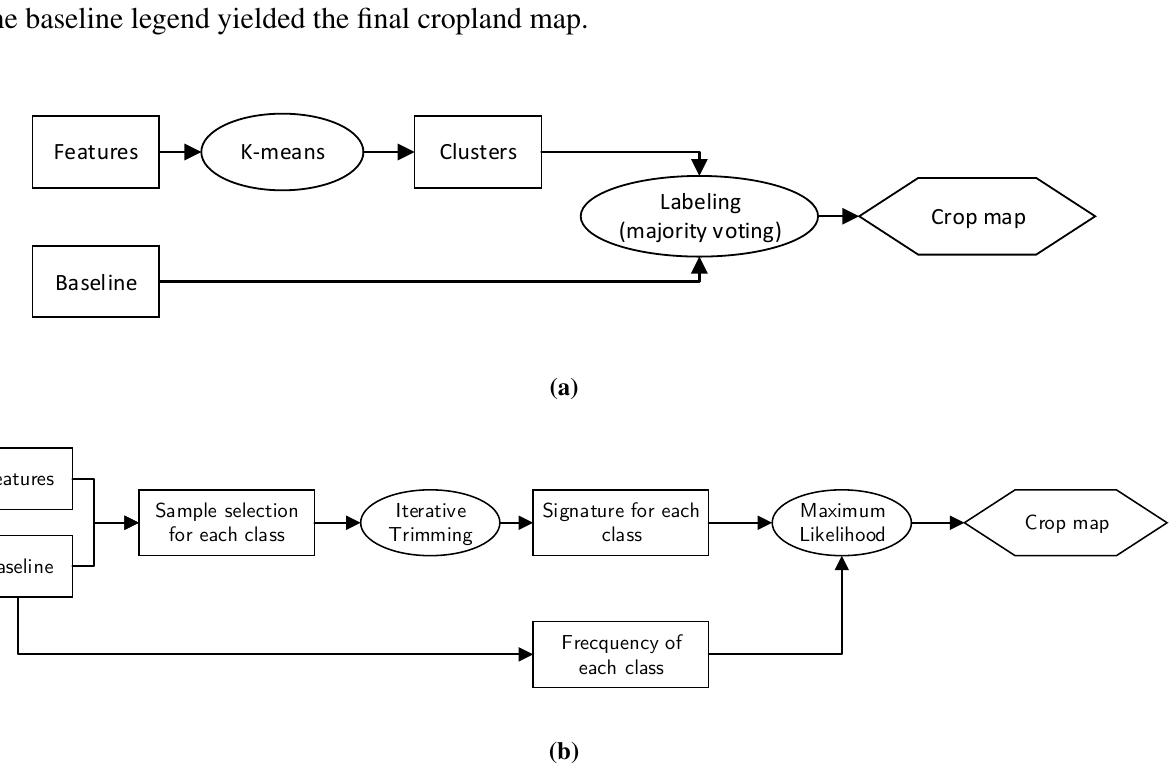
Figure 4. Flow charts for both algorithms describing the main classification steps. Boxes correspond to data (input/output); ellipses correspond to processing steps; and diamonds correspond to final results.( a ) The K-means-based approach is made up of a first step of clustering followed by majority-voting cluster labeling. ( b ) The trimming-based approach is made up of a first step of baseline cleaning (iterative trimming) followed by a maximum likelihood classifying process to produce the final